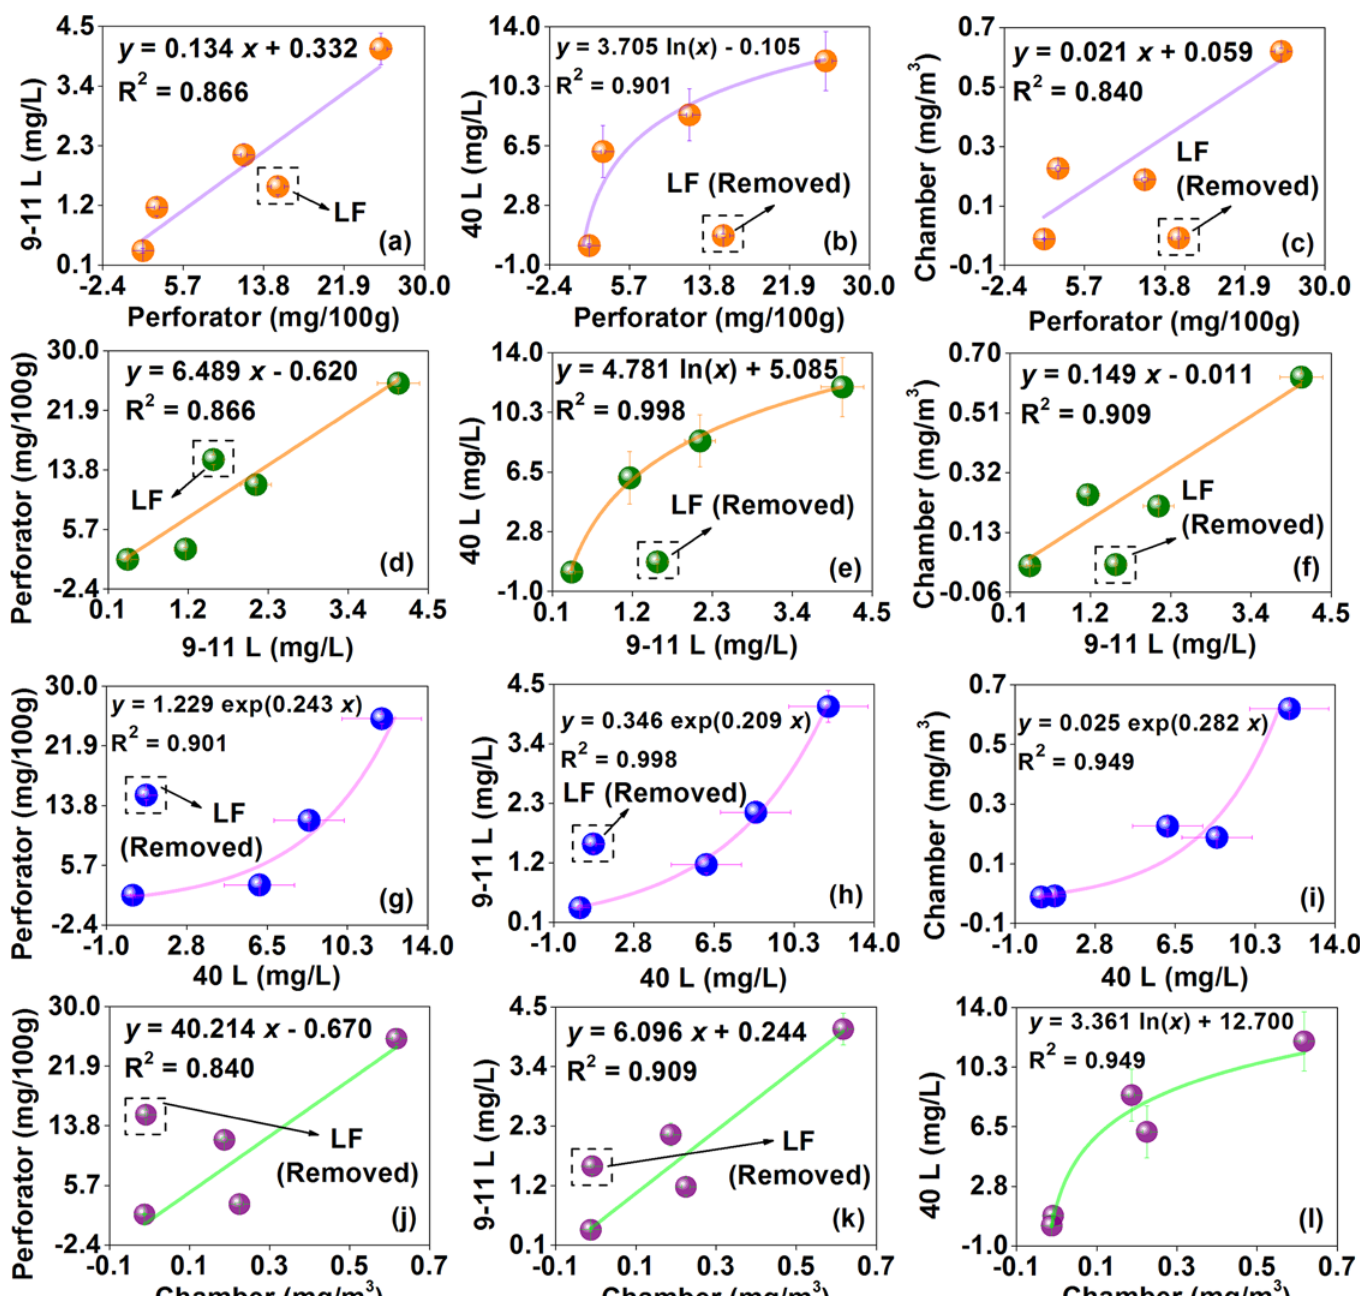
Fig 14. Empirical correlations for formaldehyde emission values of various materials characterized by different test methods of the Chinese national standard GB 18580. Perforator, the results of the perforator extraction method; 9 – 11 L, the results of the 9 – 11 L desiccator method; 40 L, the results of the 40 L desiccator method; Chamber, the results of the environmental chamber method. LF, laminate flooring. Considering that data of the laminate flooring occasionally served as an outlier, when the correlation was obviously affected by this problem, data of the laminate flooring would be marked as “ LF ” in corresponding Figs. When data of the laminate flooring were marked as “ Removed ” , in corresponding Figs, they would not be considered when